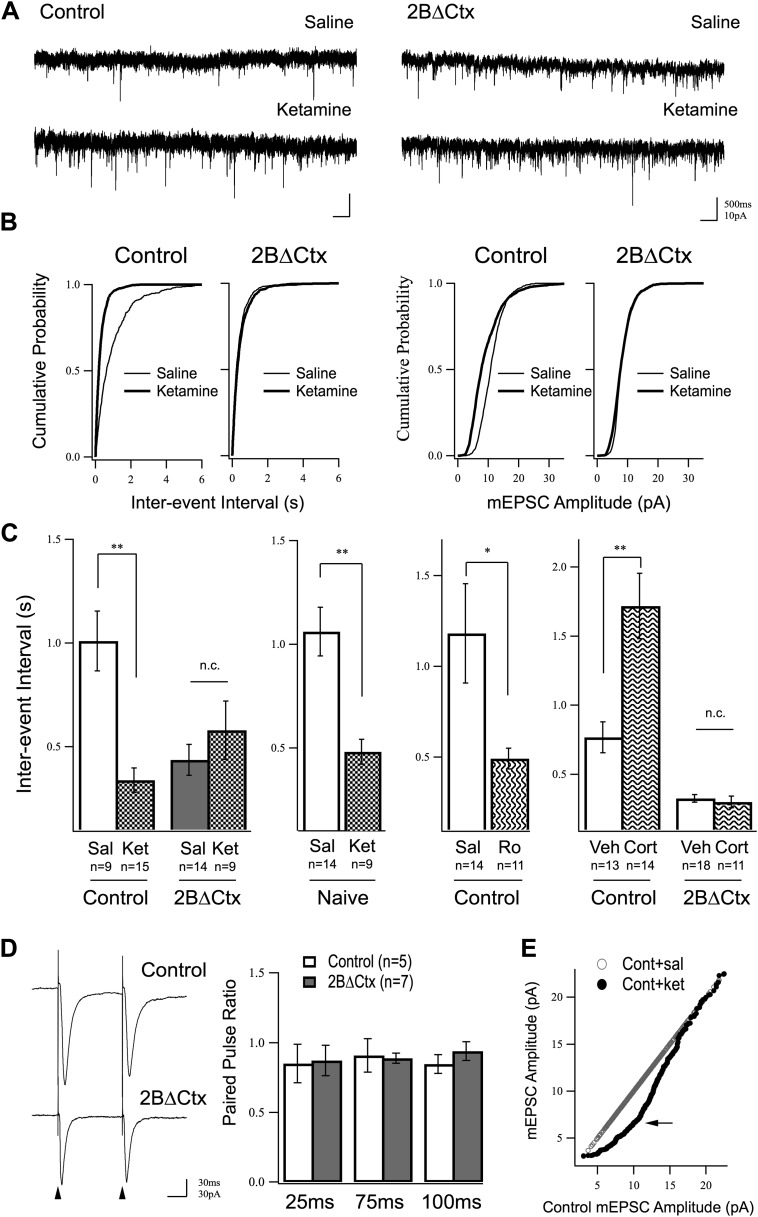
Increased excitatory synaptic transmission in prefrontal cortex following ketamine injection is occluded in 2BΔCtx animals.(A) mEPSC recordings from prefrontal layer II/III cortical pyramidal neurons 24 hr after a single injection of saline (upper) or ketamine (lower) in control and 2BΔCtx mice. (B) Cumulative histograms showing the strong increase in frequency (decreased inter-event interval) (left) of mEPSC events in control animals by ketamine is occluded in 2BΔCtx littermates. (C) Quantification and statistical IEI results are shown for data in (B). The increase in mEPSC frequency was not due to subjecting the animals to the behavioral testing as ketamine significantly suppressed IEIs in behaviorally naïve control animals. Additionally, 2BΔCtx animals showed no change in frequency of events measured after chronic corticosterone treatment, while this caused a strong decrease in event frequency in control animals. (D) The increase in event number in 2BΔCtx prefrontal cortical neurons was not correlated with a change in the paired pulse ratio measured by evoking synaptic responses at this synapse (intracolumnar stimulation indicated by the arrowheads). Example traces of evoked responses recorded by whole-cell voltage clamp at 100 ms inter stimulus interval are shown. Quantification across a number of inter-stimulus intervals is presented. (E) Ranked mEPSC plot showing the disproportionate increase in small amplitude events (arrow) in control ketamine-injected animals compared to saline injected controls. Data values are means ± sem. *p < 0.05; **p < 0.01; t test with respect to control; n.c. = no significant change.